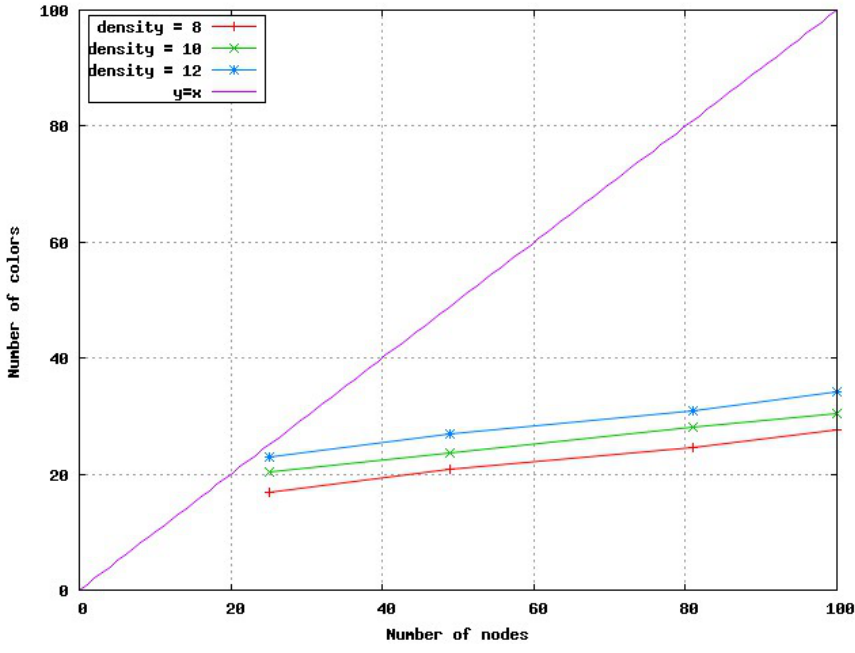
Figure 11. Number of colors in a data gathering application.